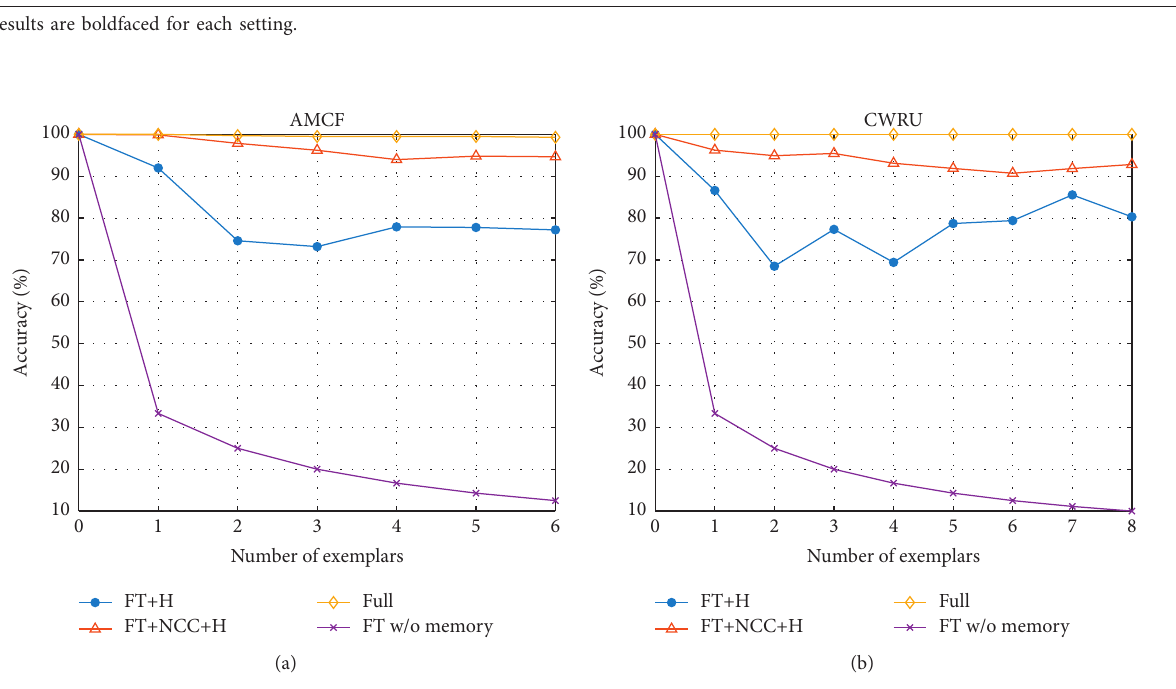
Figure 4: Impact of each component of FT +NCC+H on (a) AMCF and (b) CWRU across 6 and 8 incremental phases, retaining one exemplar per fault. Accuracy results of FT without (w/o) memory also were included.